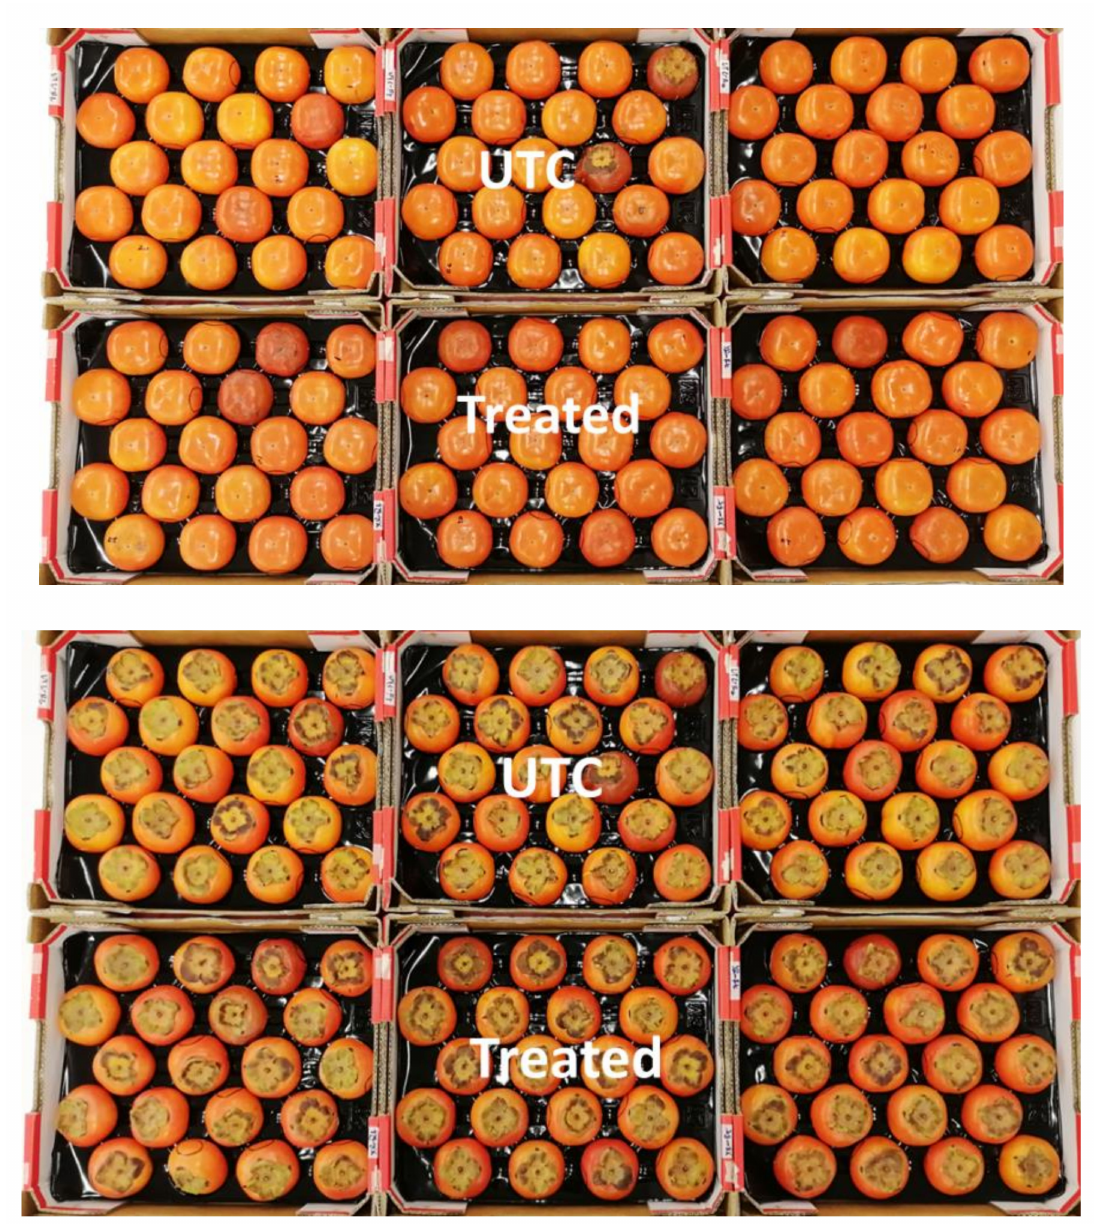
Figure 3. Untreated control (UTC) ( top ) and treated ( lower ) ‘Jiro’ persimmon fruit after three weeks storage at 15 ◦